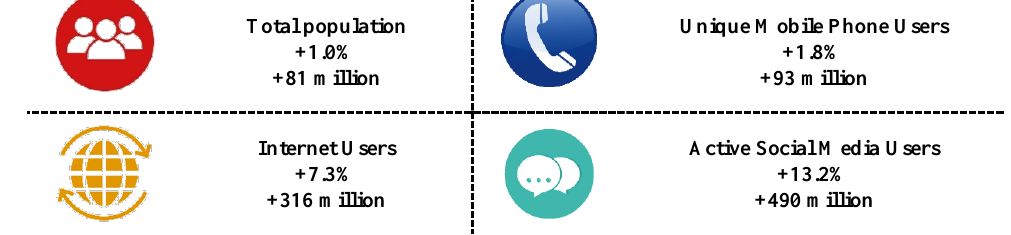
Figure 1. Global Digital Growth, January 2021 vs. January